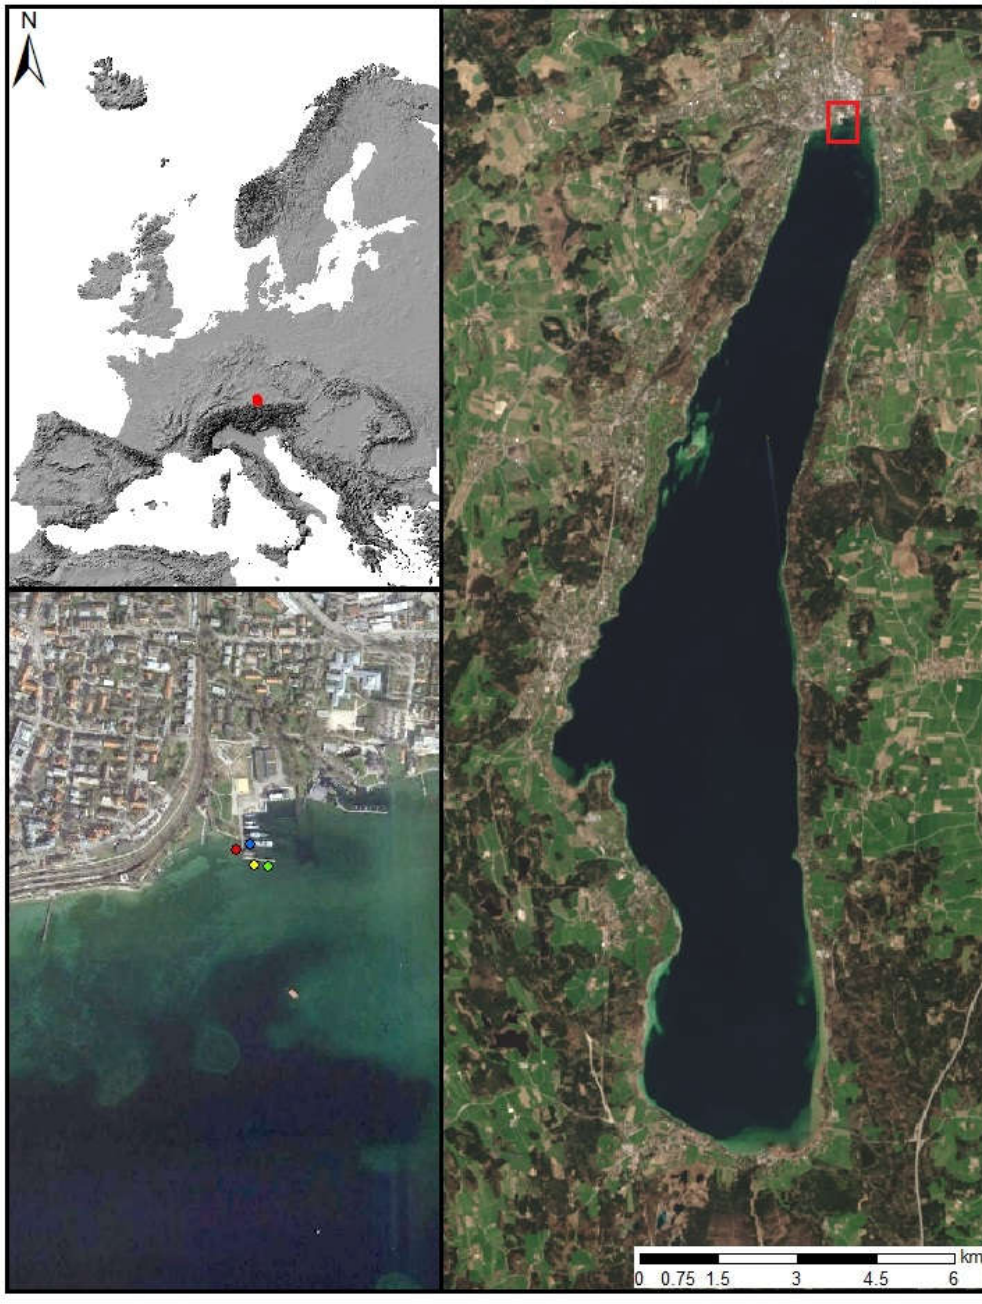
Figure 1. Study site at Lake Starnberg. Measurement points of macrophyte test sites (red: Chara , blue: E. nuttallii , green: P. perfoliatus ) and water temperature (yellow) (Google Earth Imagery, Image 2017 Landsat/Copernicus). Landsat 8 true-color composite (acquisition date: 7 April 2014; data source: USGS).